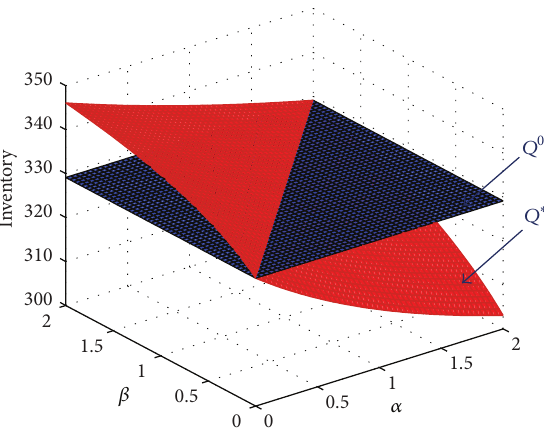
Figure 4: The effects of the loss aversions on the optimal order